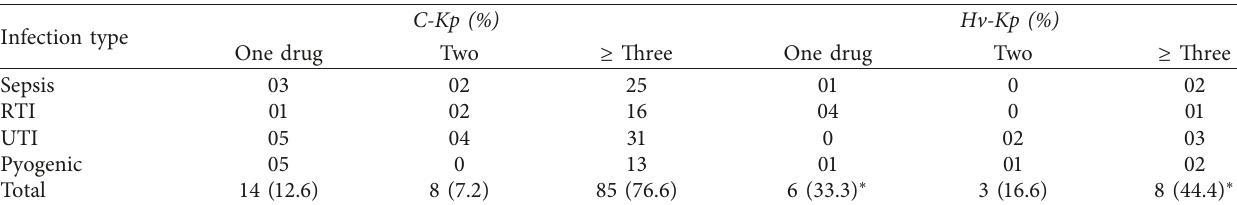
Table 4: Multidrug resistance exhibited by classical Klebsiella pneumoniae (C-Kp) and hypervirulent Klebsiella pneumoniae (Hv-Kp) isolates included in the